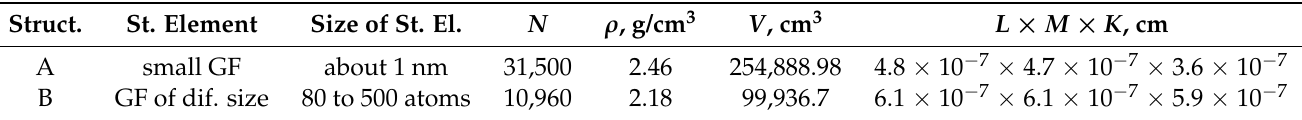
Table 1. Parameters of the initial structure of crumpled graphene: N is the number of atoms in the structure, ρ is the structure density, V is the volume of the structure, and L × M × K is the size of the structure along three dimensions. Struct. St. Element Size of St. El.